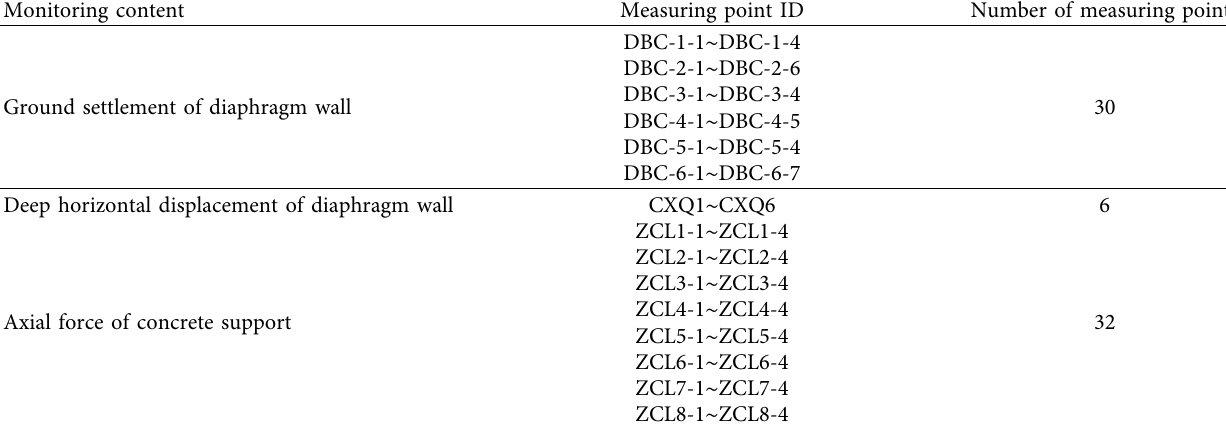
Figure 21: Layout of monitoring points. Table 13: Measuring point